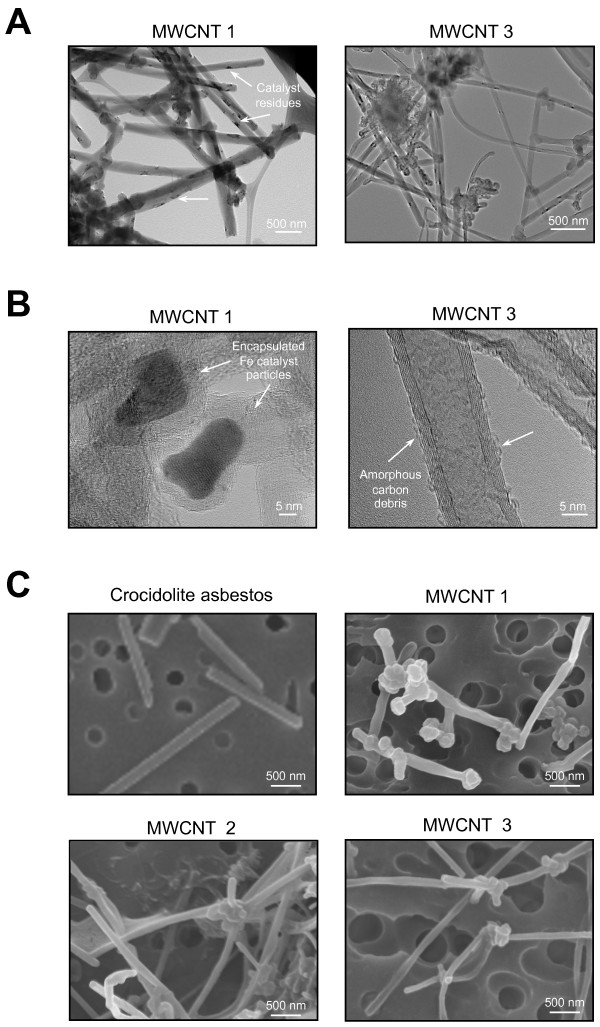
Transmission and scanning electron microscopy images of test materials. A-B) Geometry and surface features of MWCNTs. SEM imaging (A) shows individual carbon nanotubes. MWCNT 1 shows encapsulated metal catalyst residues and MWCNT 3 shows amorphous surface carbon residues as imaged using HR-TEM (B). Both samples have the characteristic crystalline structure of carbon nanotubes. MWCNT geometry shows rigid tubes, iron catalyst residues embedded on the surface and encapsulated within well-ordered walls and surface with amorphous carbon debris. Analysis by TEM and HR-TEM. C) Crocidolite asbestos fibers are individually dispersed compared to cross-linking of MWCNTs into a 3D structure as shown by SEM imaging of native dry materials.